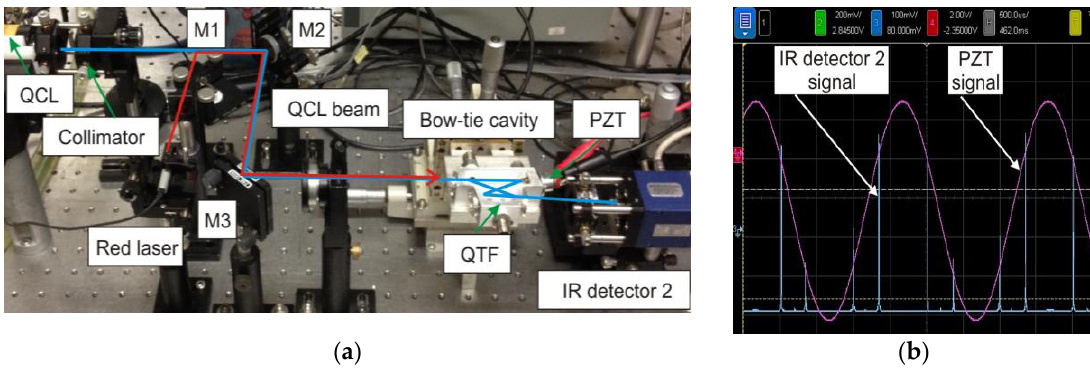
Figure 8. ( a ) Photos of the experimental setup; and ( b ) an example of recorded PZT and I-QEPAS signals.